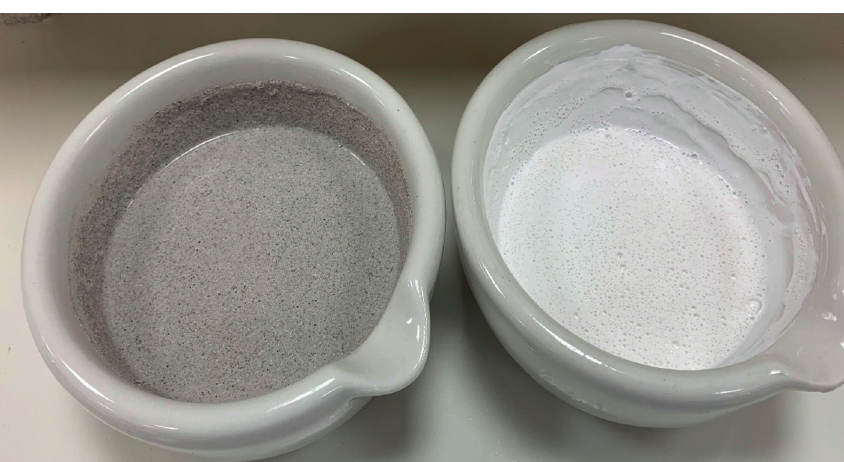
Figure 1: Preparation of experimental quail toothpaste and control toothpaste.